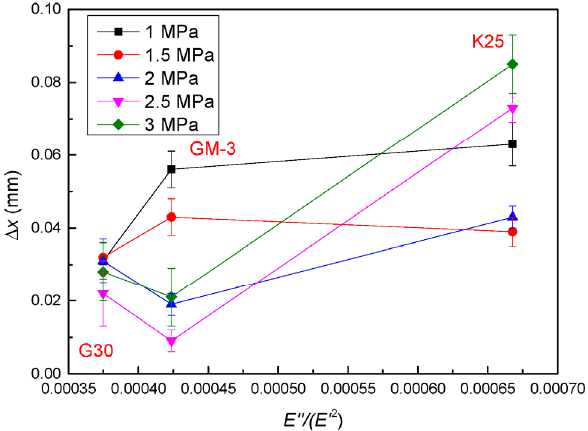
Fig. 15 Relationship between hysteresis friction and the ratio of the loss modulus to the square of the storage modulus ( E" /( E' 2 )).